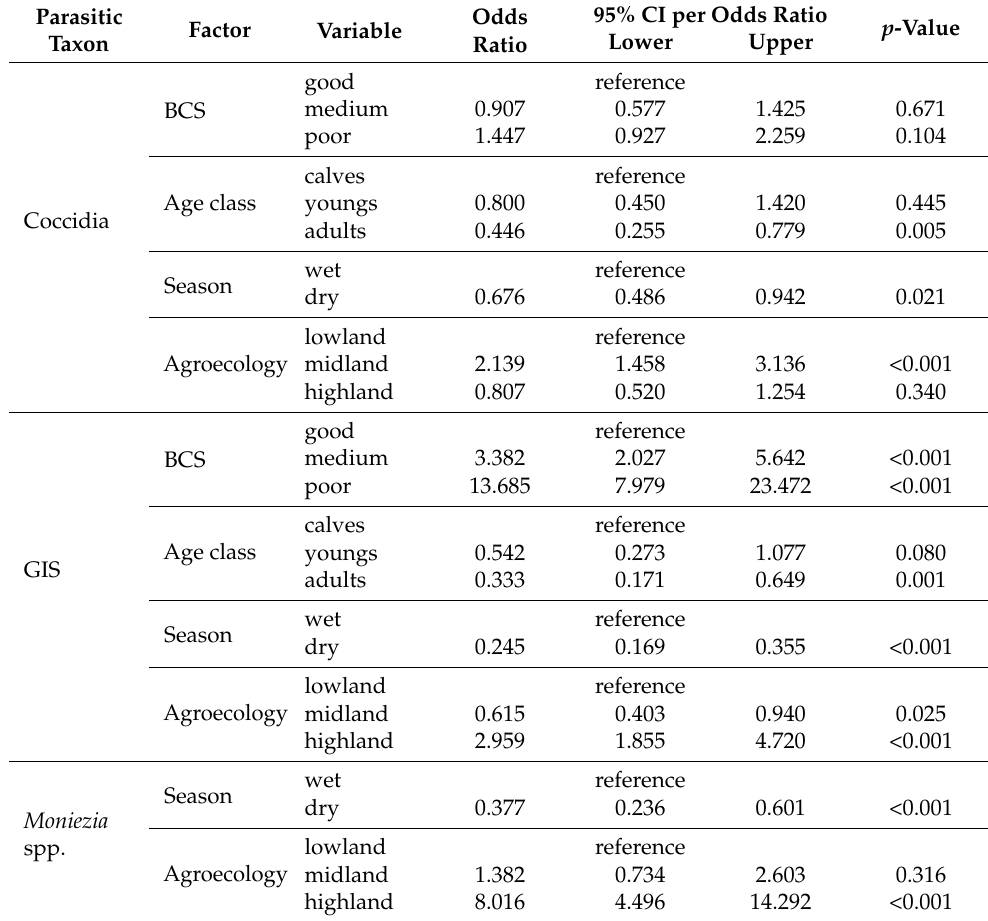
Table 4. Results of the logistic regression model for Eimeria spp. (Hosmer–Lemeshow test: p = 0.597), GIS (Hosmer–Lemeshow test: p = 0.092) and Moniezia spp. (Hosmer–Lemeshow test: p =